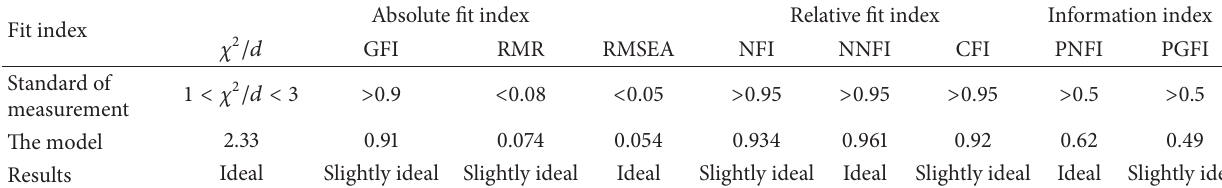
Table 15: The analysis of fit degree of the